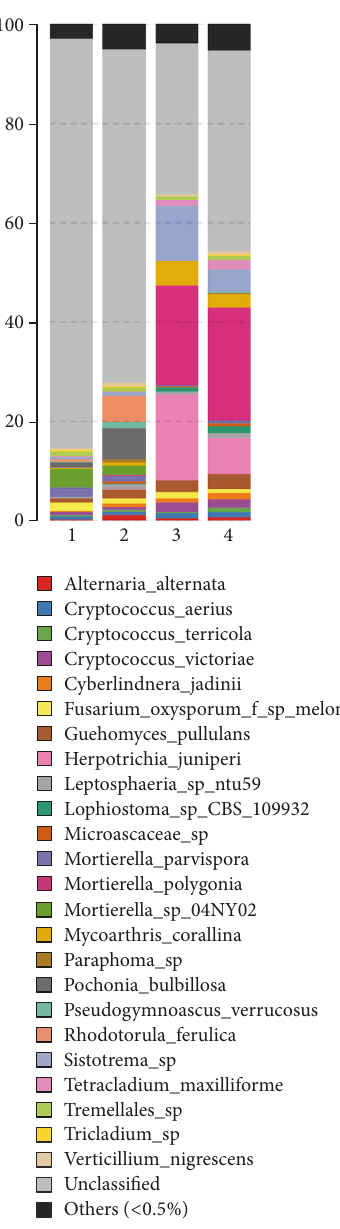
Figure 2: Relative abundance of fungal genera. Samples 1 and 2 represent the two replicates of relatively unhealthy soil samples, while Samples 3 and 4 represent the two replicates of relatively healthy soil